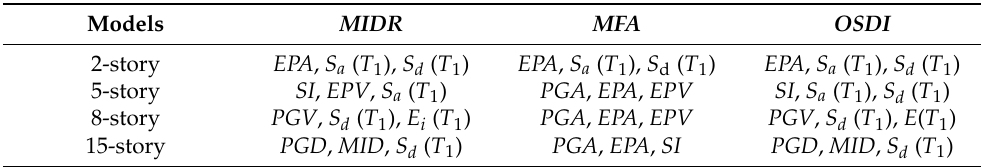
Table 6. The most efficient IMs for different typical